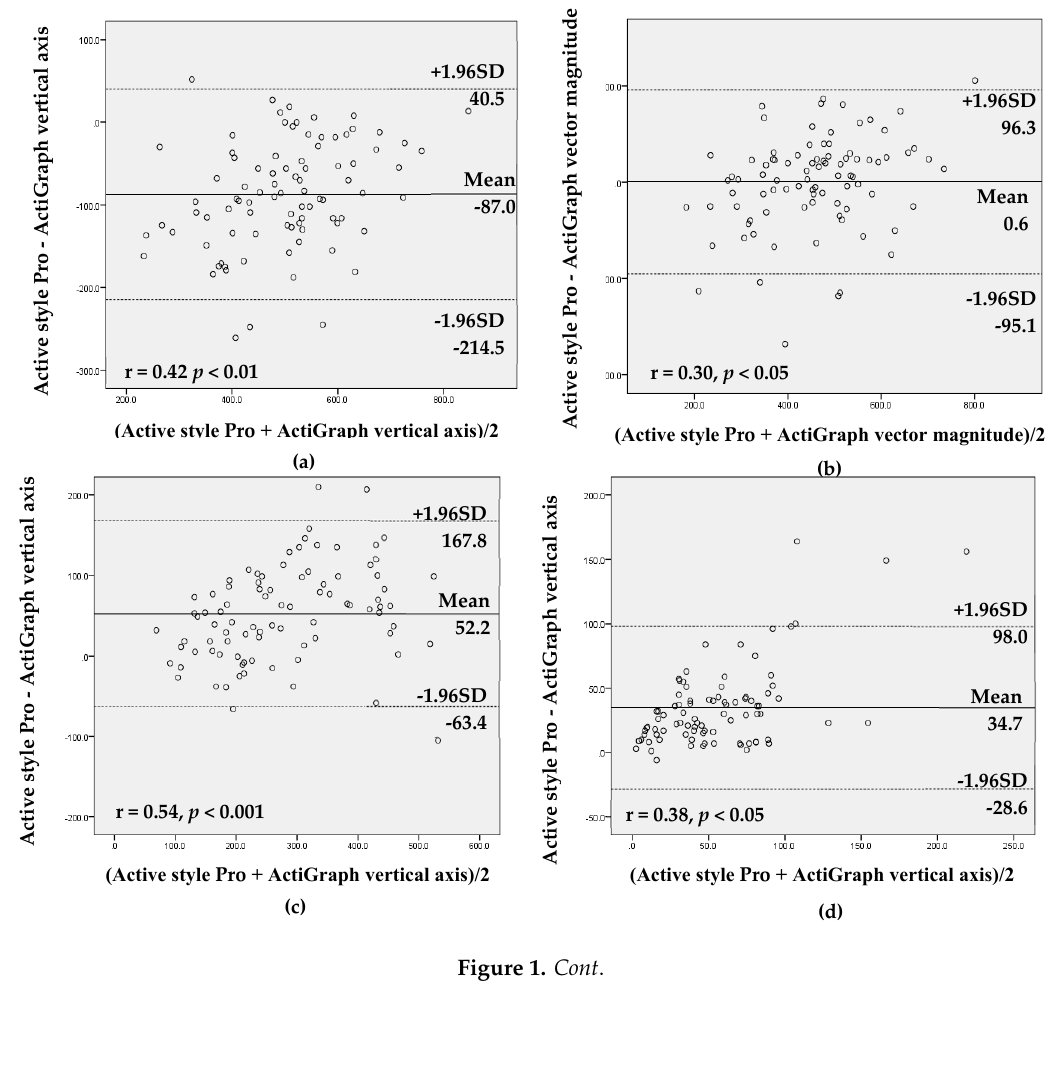
Table 2. The mean differences of PA output between Active style Pro and